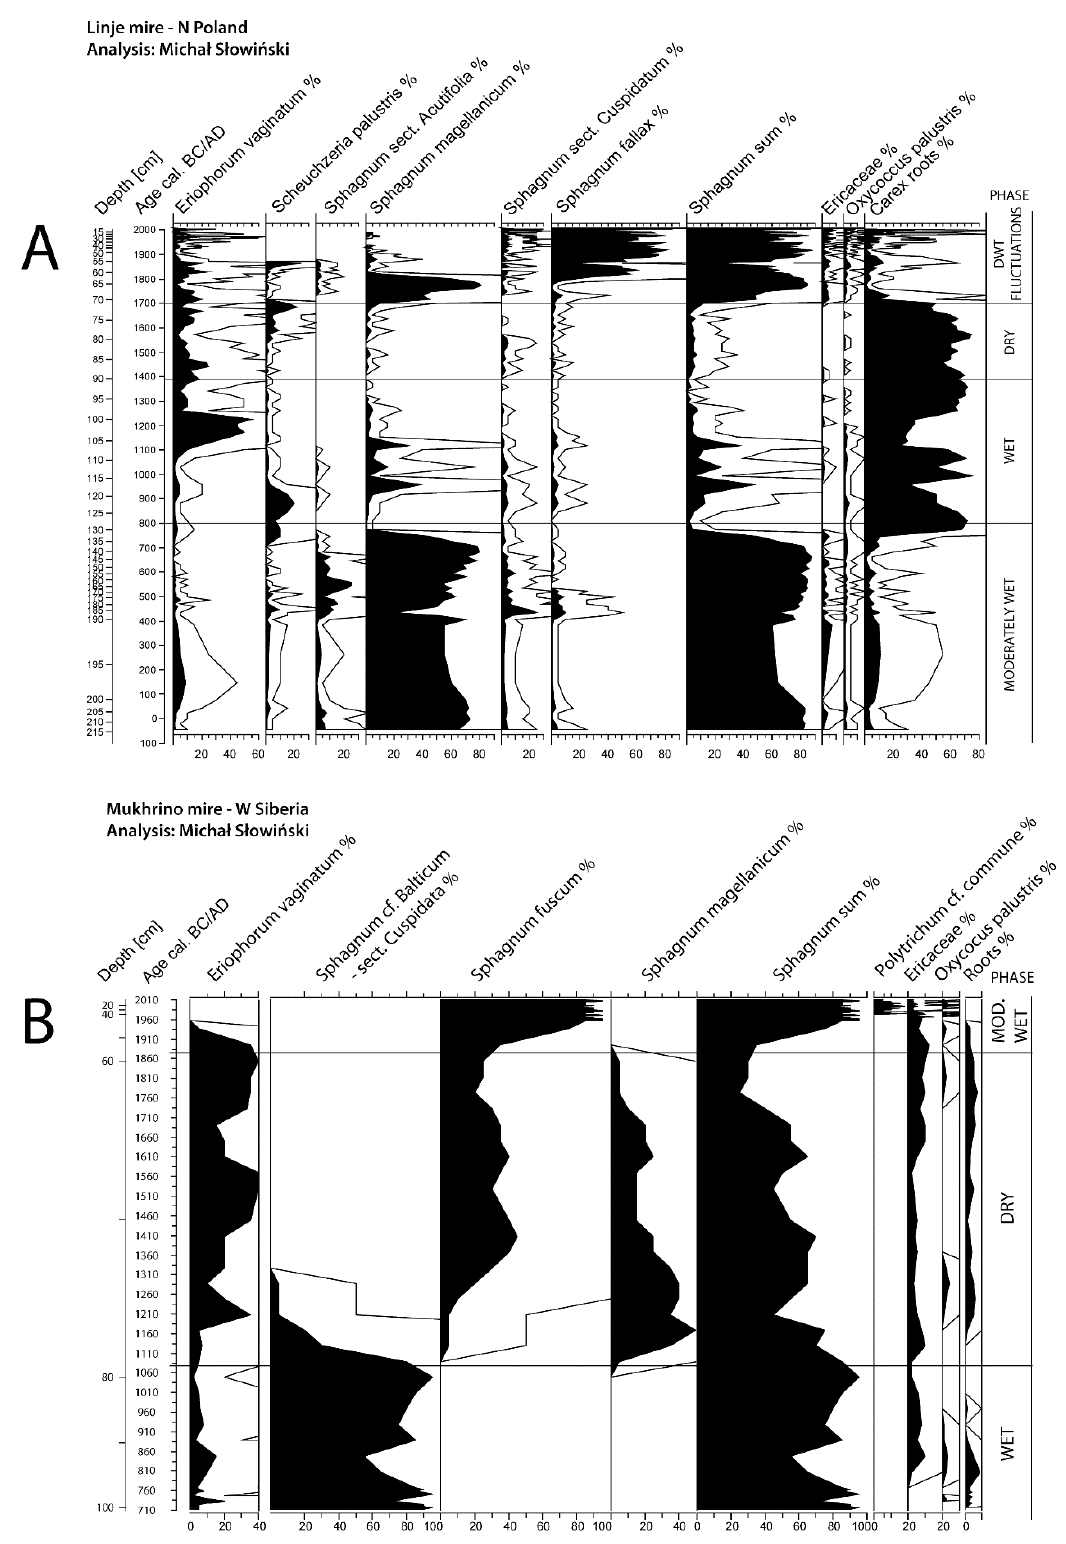
Figure 9. (A) Plant macrofossils analysis from Linje Mire. Four stages of peatland development are marked, from the moderately wet and pristine (domination of Sphagnum magellanicum ) to hydrologically unstable modern peatland (domination of Sphagnum fallax ) (modified from Marcisz et al . 2015). (B) Plant macrofossils analysis from Mukhrino mire. Three stages of peatland development are marked, from wet (domination of Sphagnum cf. Balticum ) to moderately wet modern peatland (domination of Sphagnum fuscum ) (modified from Lamentowicz et al.